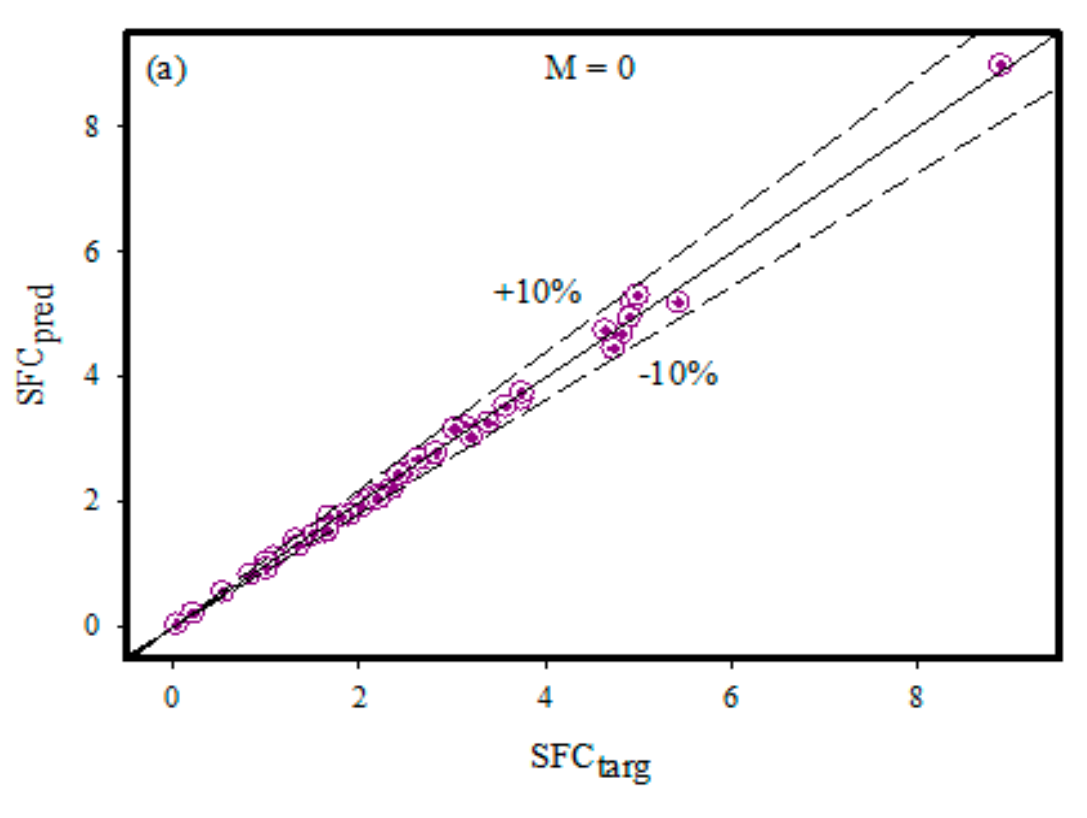
Figure 8. ( a , b ). The differences between the target values and the ANN outputs for each set of data when M = 0 and M = 0.2.